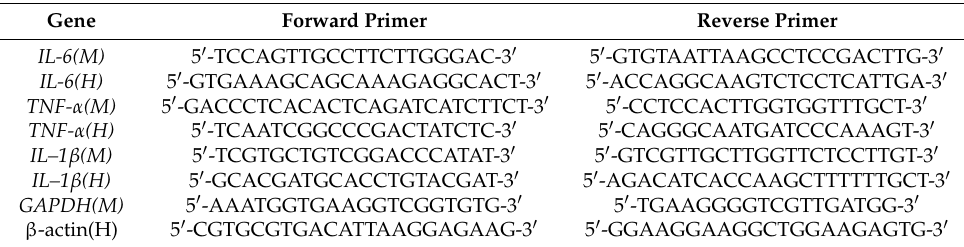
Table 1. Mouse (M) and human (H) primers for